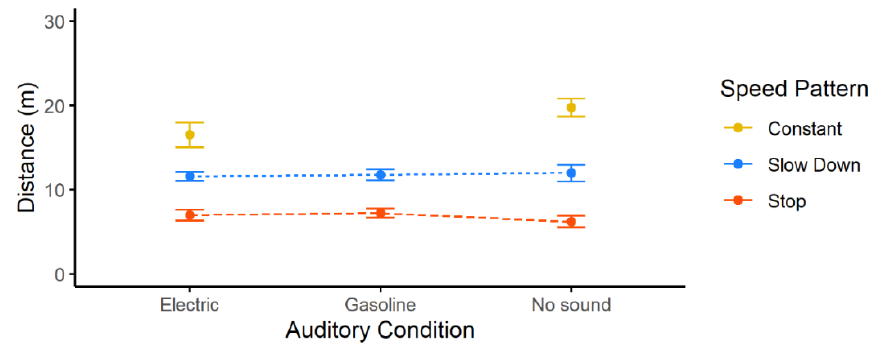
Figure 7. Mean distance between the vehicles and participants at the moment of the participants’ responses and respective mean standard error as a function of auditory condition, per vehicle speed pattern.